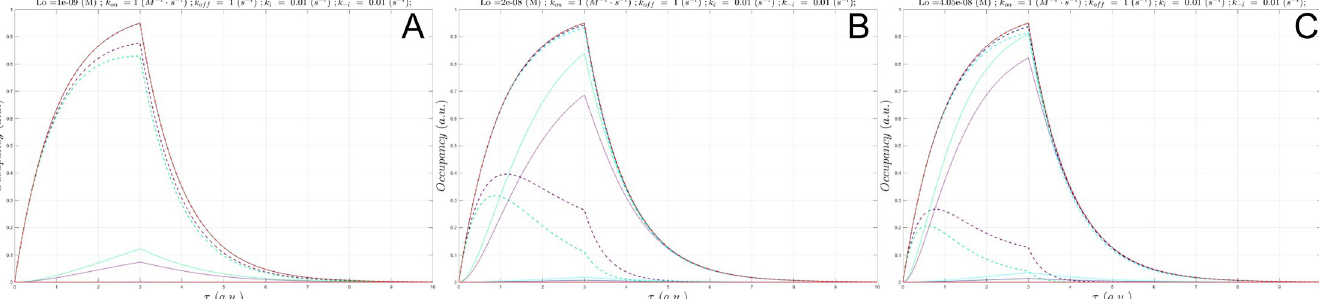
Fig 13. (A) Plot of the hypothetical B ( τ ) (gray) and c ( τ ) for PCSK9 and PCSK9-LDL-R binding at a fixed PCSK9 L 0 = 1 nM, Λ = 5 min ( k total k on and k off values given in Table 2 (solid lines color-coded as follows: wt /pH 7.4 dark blue (not visible); wt /pH 5.3 purple; D374Y/pH 7.4 cyan; D374Y/pH5.3 green), ( τ ) (dotted lines color coded the same as c ( τ )). Simulated occupancy is essentially zero for both wt and mutant PCSK9 at neutral pH, whereas negligible nSSO is and B free achieved at low pH. (B) Same as A, except L 0 = 0 nM. Moderate nSSO is achieved at low pH (maximum occupancy = 68% versus 75% for the wt and mutant forms, respectively). (C) Same as A, except L 0 = 40.5 nM. High nSSO is achieved at low pH, where the gap between wt and mutant forms narrows to only a few percent at all time points (maximum occupancy = 82% versus 85% for the wt and mutant forms,